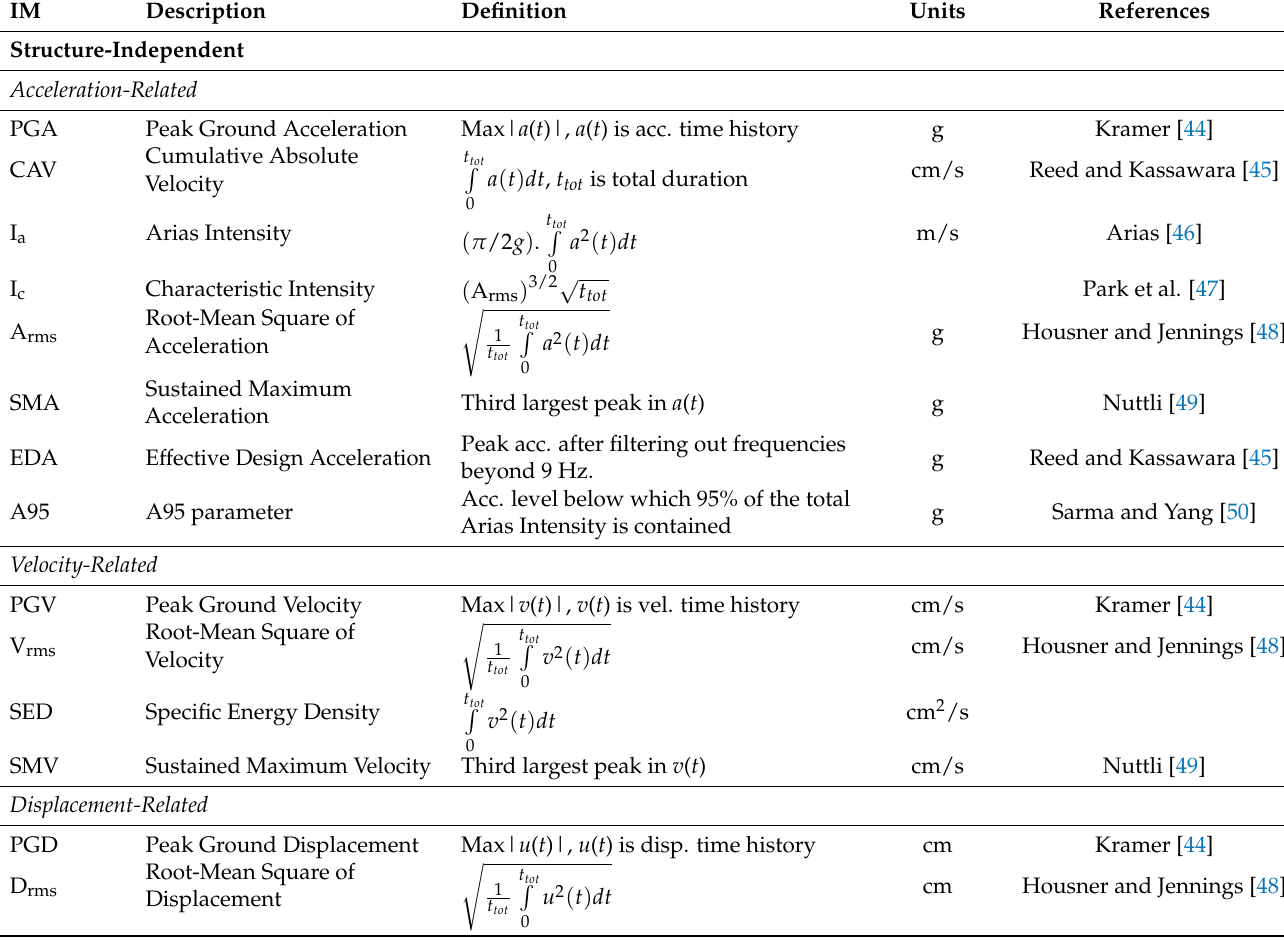
Table 2. Lists of considered Intensity Measures .